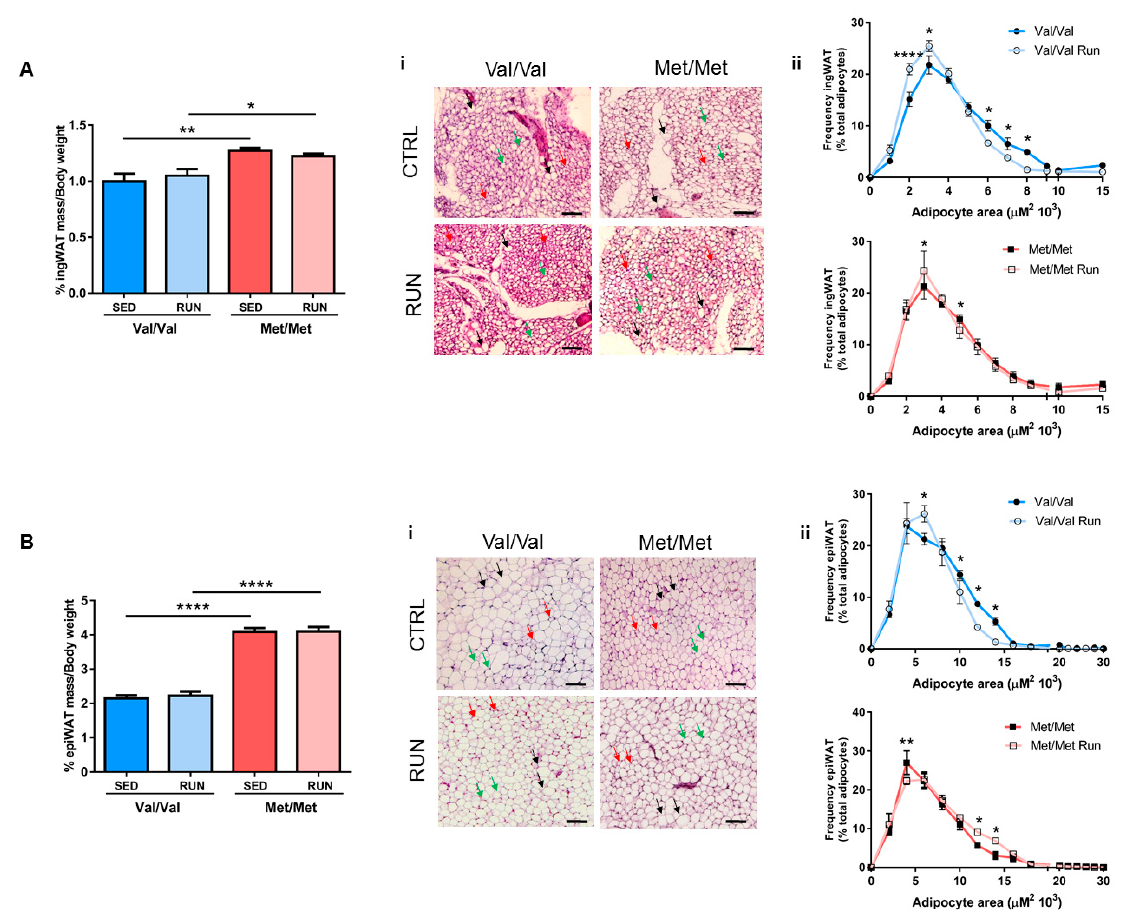
Figure 4. Impact of voluntary physical exercise (PE) on epiWAT morphology. ( A ) Inguinal (ingWAT) and ( B ) epidydimal (epiWAT) white adipose tissue on total mouse body weight. (i) Representative hematoxylin and eosin (H&E) staining images and (ii) analysis of the frequency distribution of adipocyte sizes in ( A ) ingWAT and ( B ) epiWAT. Size bar: 100 µ m. Black arrow: large adipocytes, green arrow: medium adipocytes, and red arrow: small adipocytes. Data are expressed as mean ± SEM. n = 6 mice / group. Two-way ANOVA followed by Bonferroni post hoc analysis. * p < 0.05, ** p < 0.01, and **** p < 0.001.